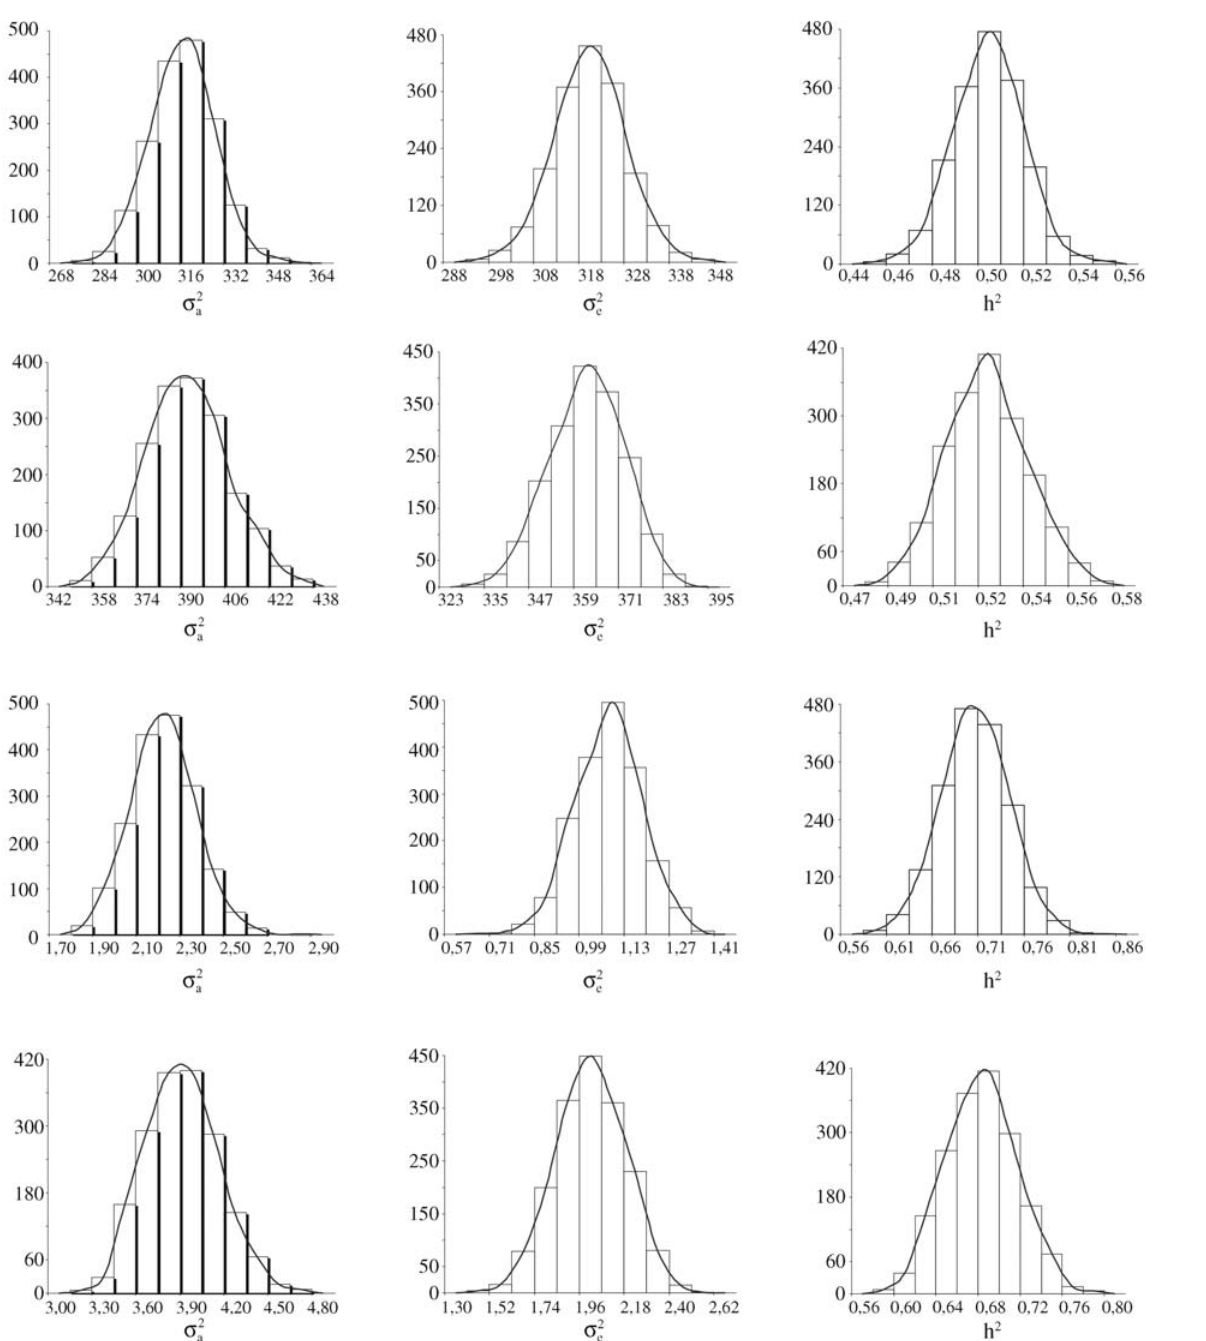
Figure 1 - Histograms of posterior densities estimates of additive genetic variance ( σ a2 ), residual variance ( σ e2 ), and heritability ( h 2 ) for weight at 365 (up- per) and 450 days of age (upper middle), scrotal circumference at 365 (lower middle) and 450 days of age (lower) from a single-trait analyses using Gibbs